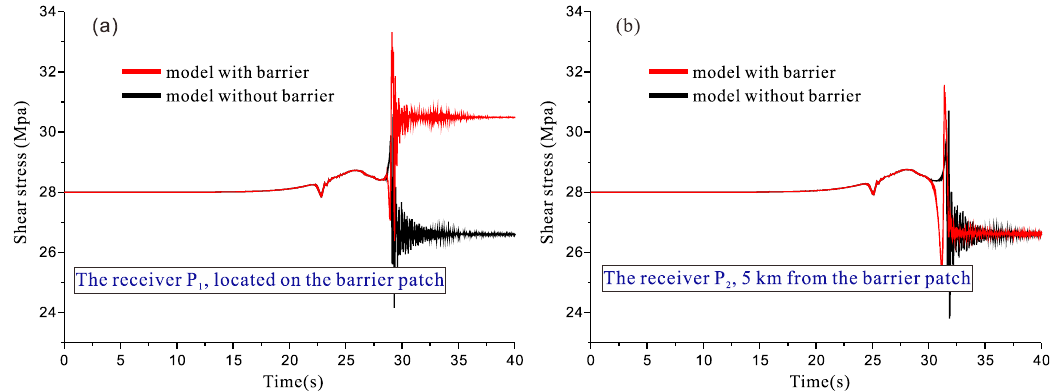
Figure 5. ( a ) Shear stress at the receiver P1 on the barrier patch (corresponding position in the model without a barrier) and ( b ) shear stress at the receiver P2, 5 km in front of the barrier patch.